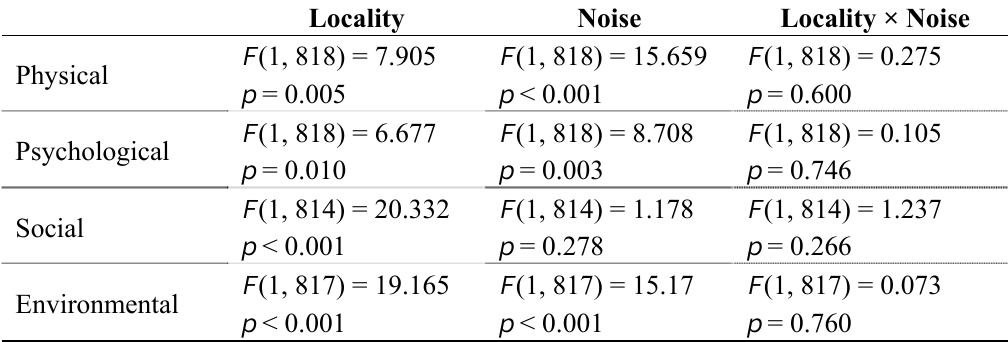
Table 2. F -values for tests of main and simple effects between locality (rural versus city) and noise grouping (noisy versus quiet) in terms of WHOQOL-BREF domain